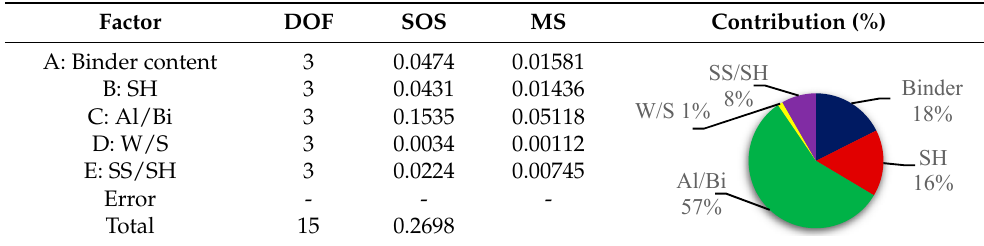
Table 8. Results of confirmation